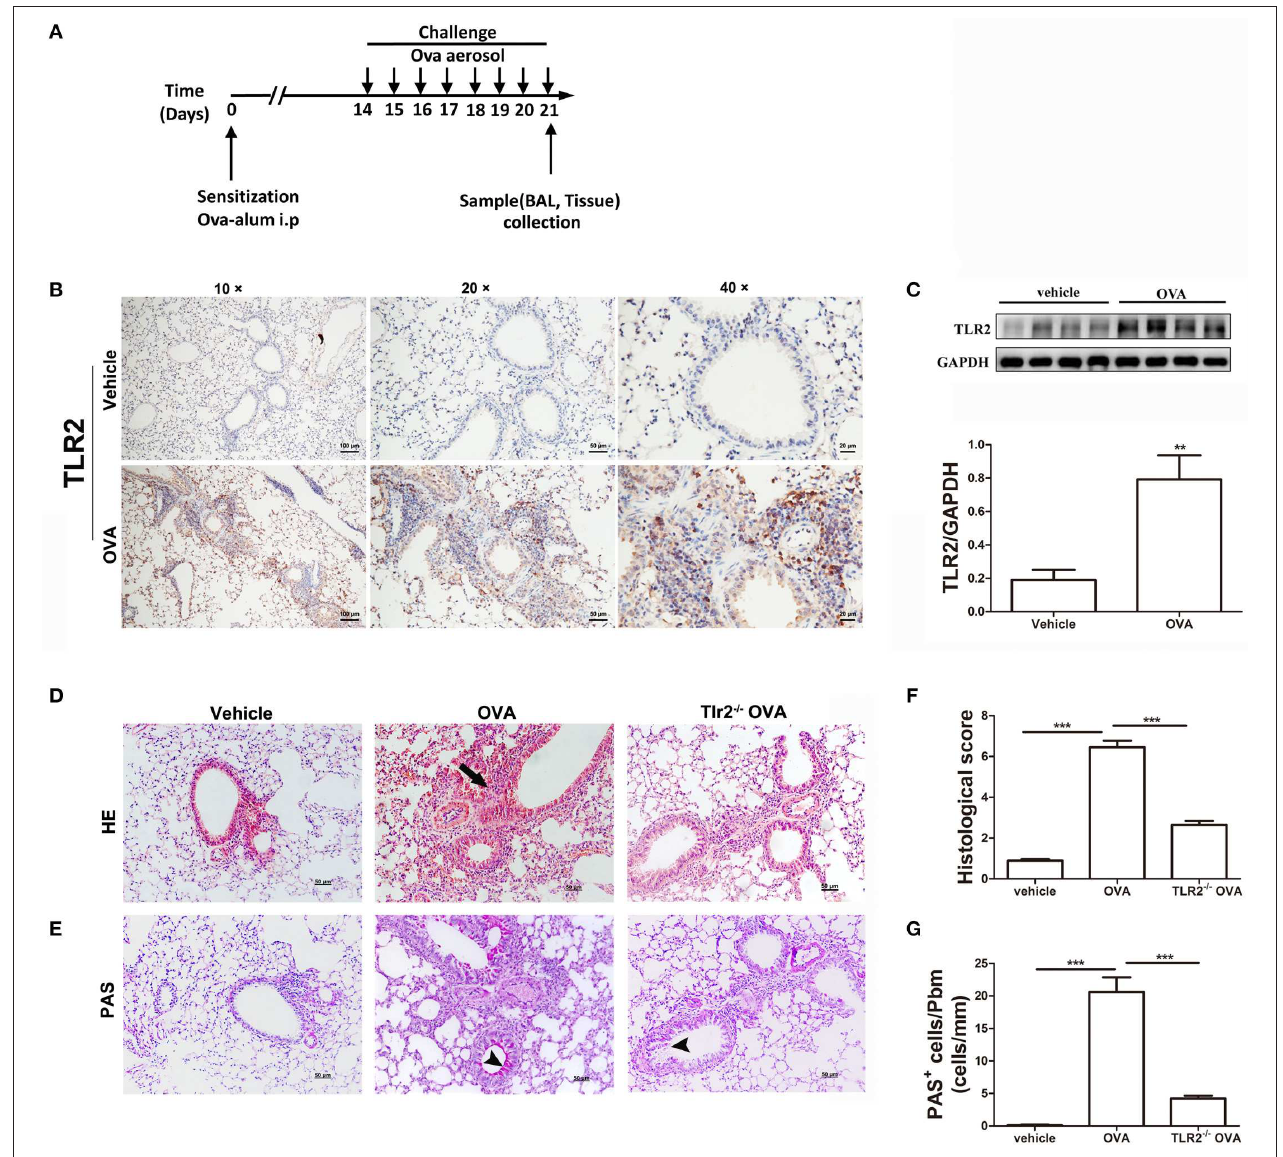
FIGURE 1 | TLR2 is required for OVA-induced murine allergic airway inflammation. (A) Protocol of establishing allergic airway inflammation, and comparison of resolution of WT and TLR2 − / − mice. (B) The expression of TLR2 in lung tissue from vehicle and OVA-challenged mice was analyzed by immunohistochemistry. (C) The protein expression of TLR2 in OVA-challenged WT mice analyzed by western blot and quantification of the protein expression of TLR2. (D) Histological evaluation of the airway inflammation by staining lung sections with H&E, arrows indicates infiltrated leukocytes. (E) Histological examination of mucus production in the lung sections stained with PAS, arrow heads indicates goblet cells. (F) Quantitative analysis of airway inflammation. (G) Quantitative of mucus production. Scale bar: 50 µ m. ** p < 0.01, *** p <